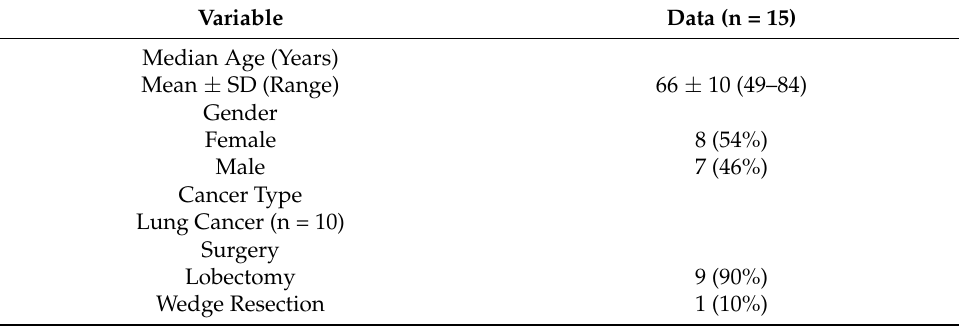
Table 1. Characteristics of patients with thoracic